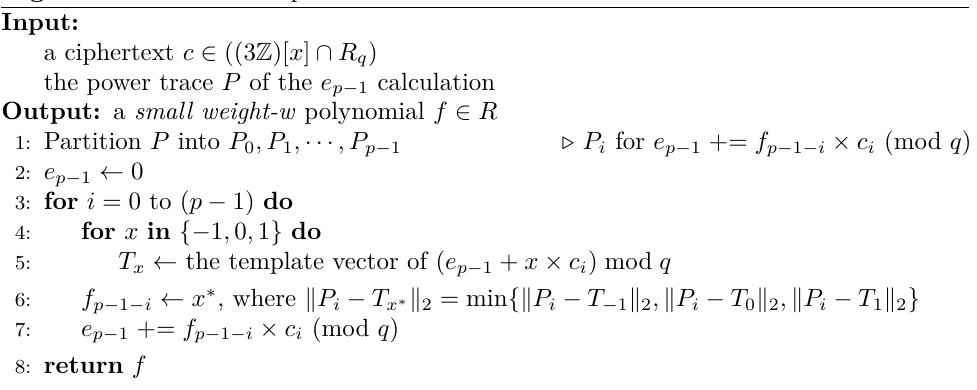
Algorithm 4 Online Template Attack on NTRU Prime